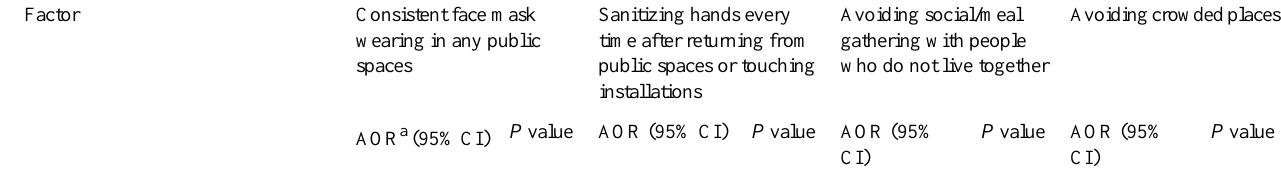
Table 7. Factors associated with self-reported compliance with different personal preventive measures.